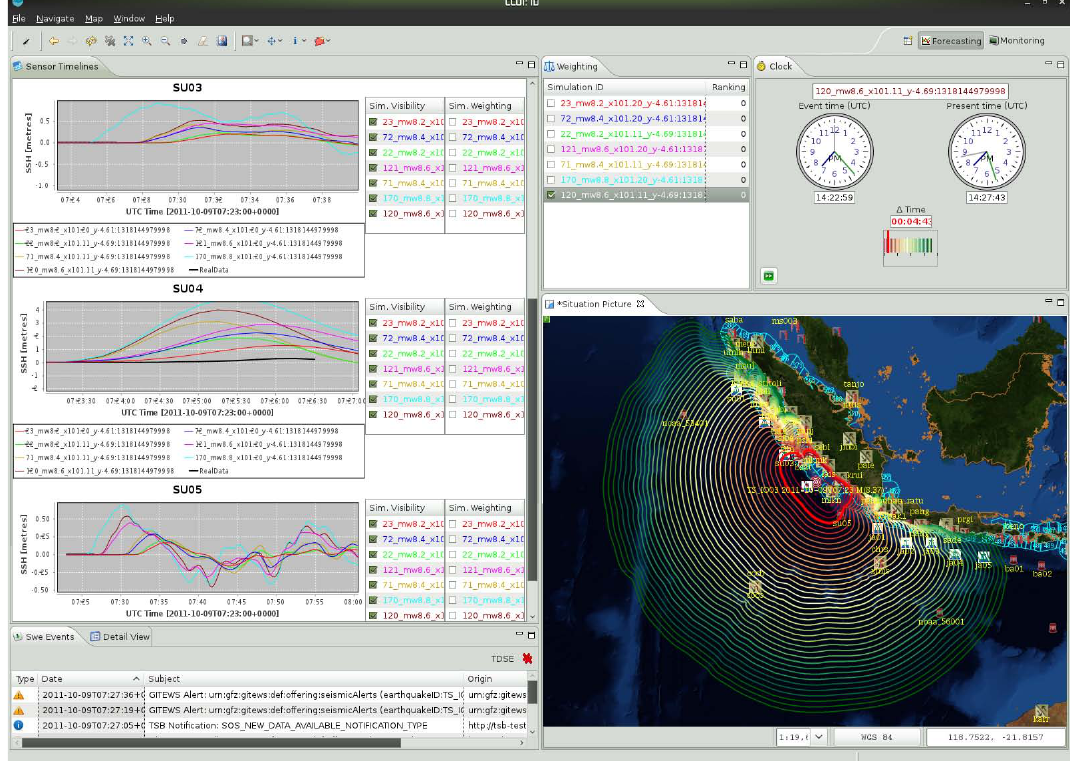
Fig. 7. Forecasting